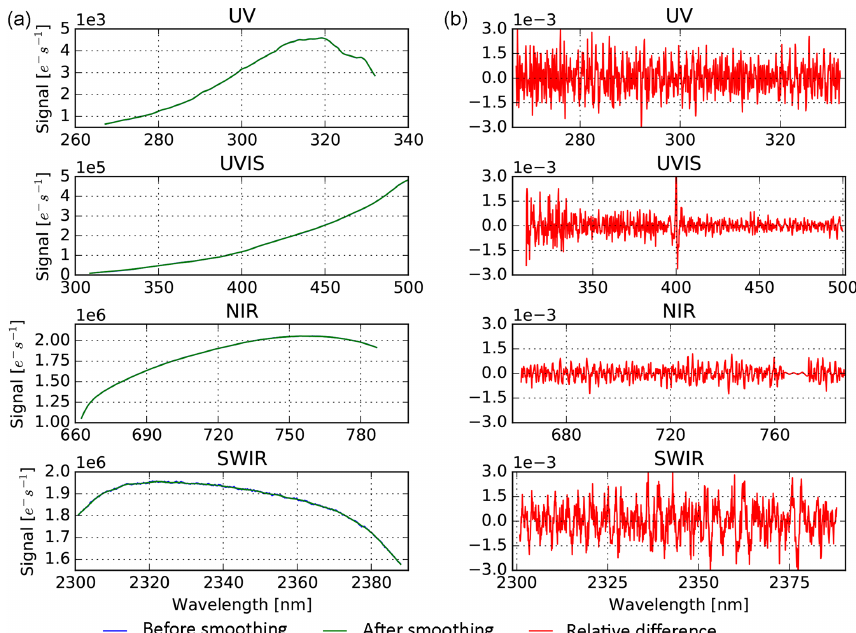
Figure 12. Typical results of spectral smoothing. (a) For each detector, signals before (blue lines) and after smoothing (green lines); except for SWIR, differences between both signals are hardly visible on these scales. (b) Corresponding (relative) residuals as a ratio to the original signal, showing mainly highly frequent differences between the unfiltered and filtered signals. Somewhat lower-frequency features may be observed in the residuals for SWIR (e.g. between columns 850 and 900), but there is no correlation between these and similar features obtained for diffuser DIF2 (not shown), indicating that the effects are diffuser-borne. The “gap” in the NIR residuals between columns 800 and 900 corresponds to the interpolated oxygen A band.